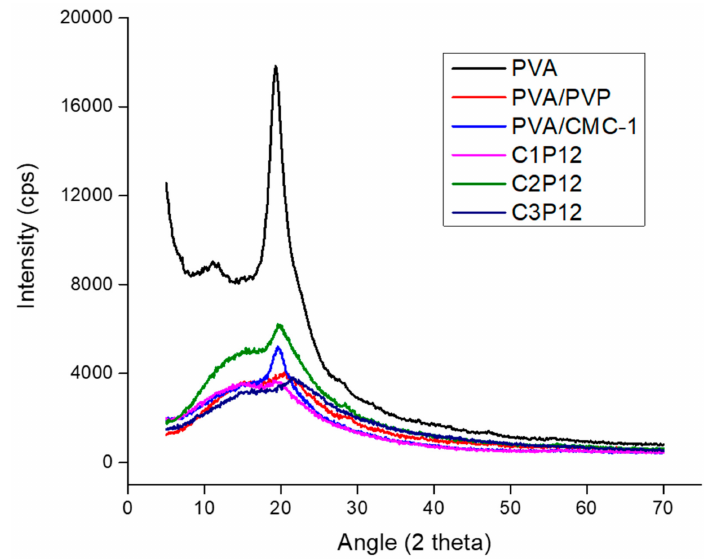
Figure 6. X-ray diffraction (XRD) spectra of PVA, PVP, and PVA/PVP/CMC